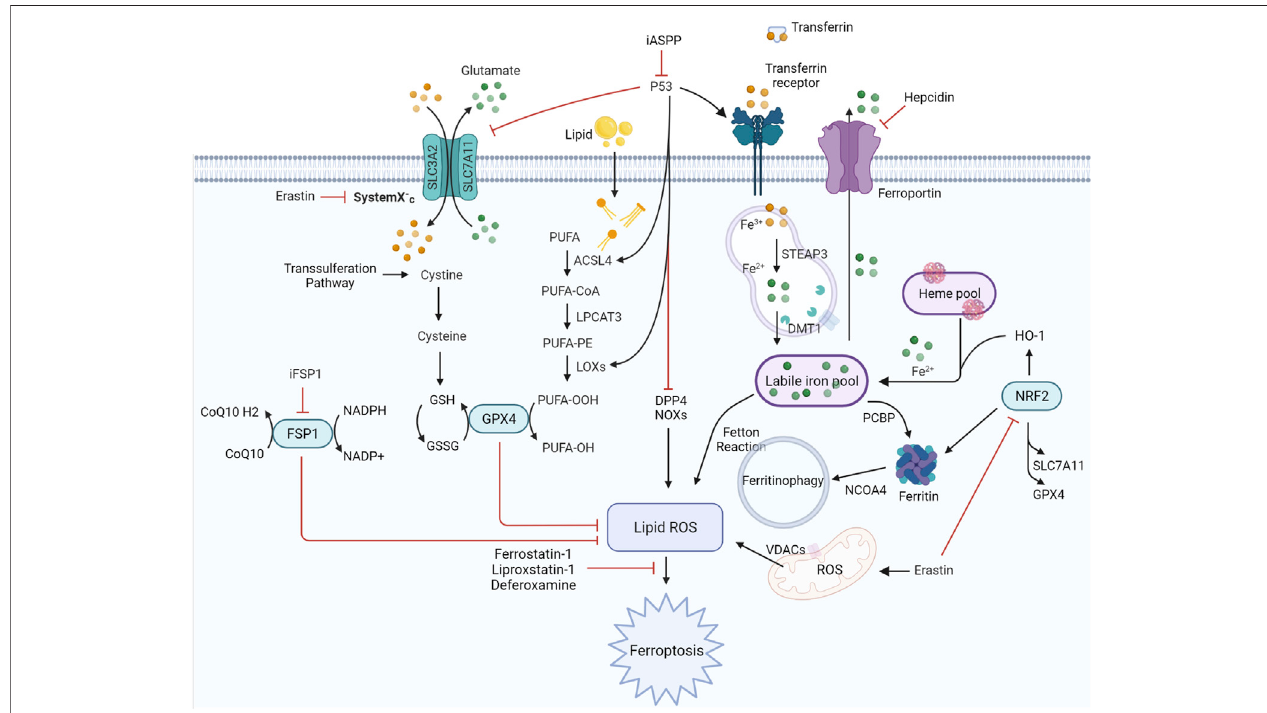
FIGURE 1 | Regulatory signaling pathways implicated in ferroptosis. The features of ferroptosis include the substrate of lipid peroxidation (PUFA), executor of lipid peroxidation (ironmetabolism), andanti-ferroptosissystems(GPX4-centeredandp53-centeredsystems).ACSL4,acyl-CoAsynthetaselong-chain family member four; DDP4,dipeptidylpeptidase-4; DMT1,divalentmetaltransporter1;FSP1, ferroptosissuppressor protein 1;GPX4,glutathioneperoxidasefour;GSH,glutathione;HO-1, heme oxygenase 1; iASPP, inhibitor of apoptosis stimulating protein of p53; iFSP1, FSP1 inhibitor 1; LOXs, lipoxygenases; LPCAT3, lysophosphatidylcholine acyltransferase three; NRF2, nuclear factor erythroid 2-related factor 2; NCOA4, nuclear receptor coactivator four; PCBP, poly (RC)-binding proteins; PUFA, polyunsaturatedfattyacid;ROS,reactiveoxygenspecies;SLC3A2,solutecarrierfamilythreemember2;SLC7A11,solutecarrierfamilysevenmember11;STEAP3,six- transmembrane epithelial antigen of prostate three; VDACs, voltage-dependent anion